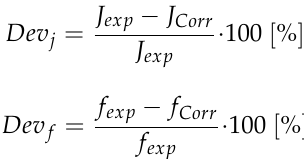
Figure 3. Experimental vs correlation calculations for offset 1/8-15.2. ( a ) Colburn factor Equation (41), ( b ) friction factor